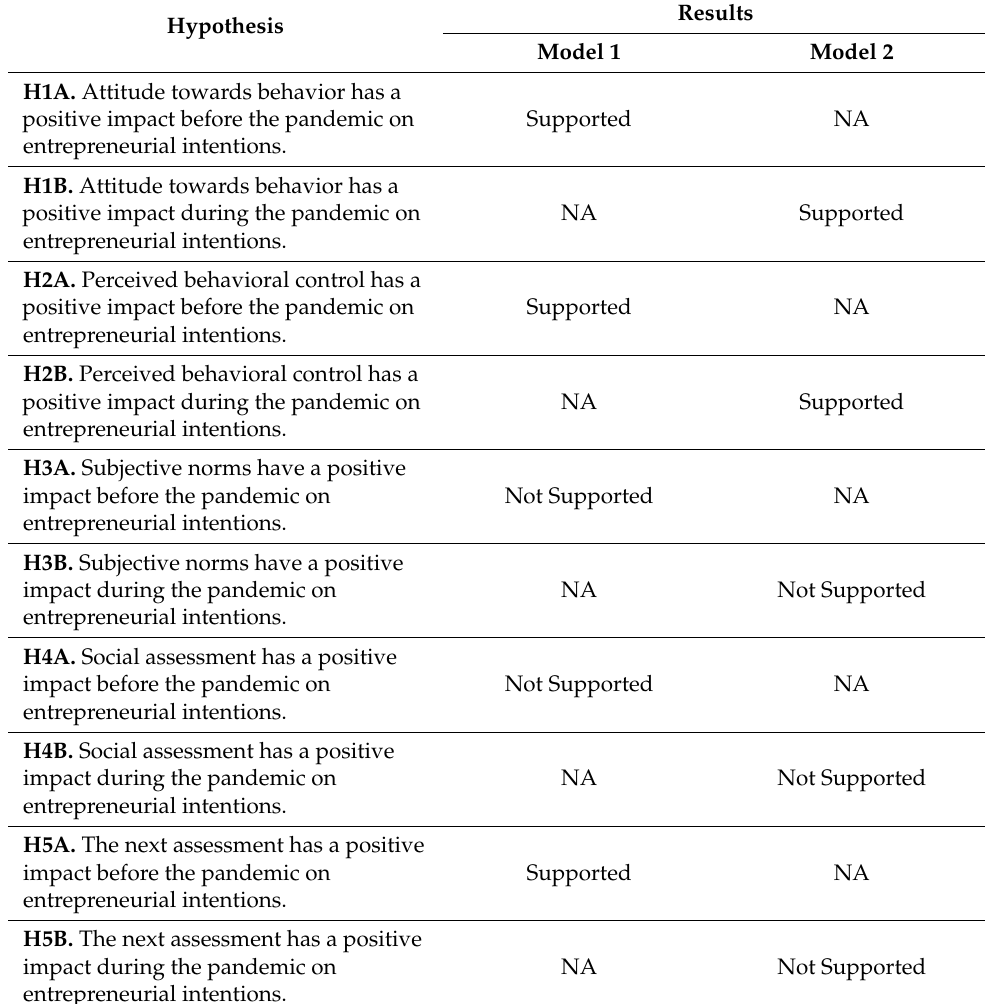
Table 9. Summary of Hypothesis